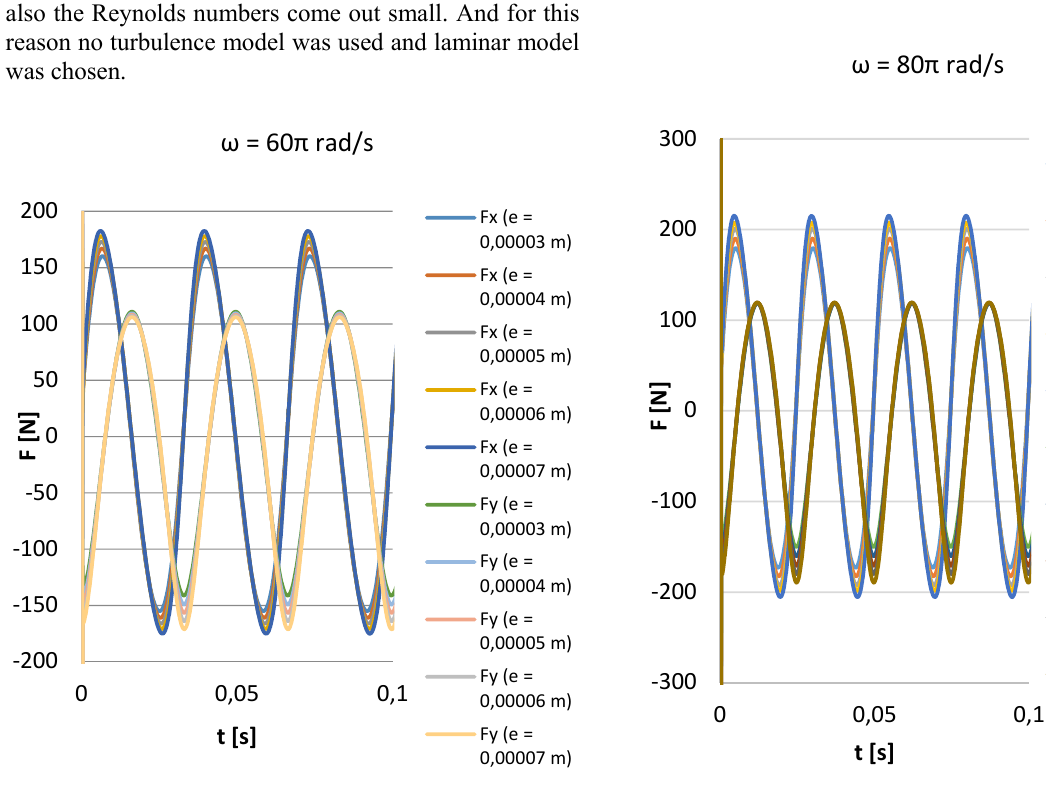
Fig. 6. Force components for ω = 80 π